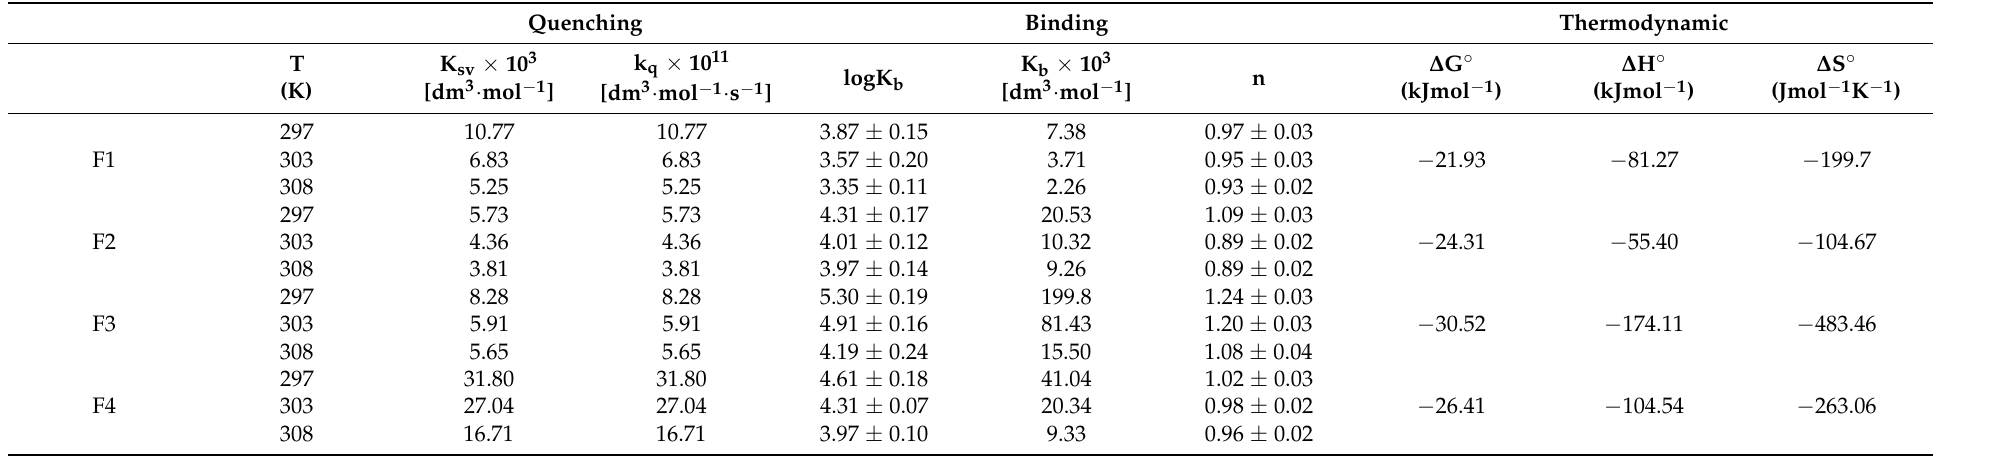
Table 3. The Stern–Volmer constant, K sv, quenching rate constant, k q , binding constant, K b, number of binding sites, n, and thermodynamic parameters for the interaction of GG with the studied compounds at different